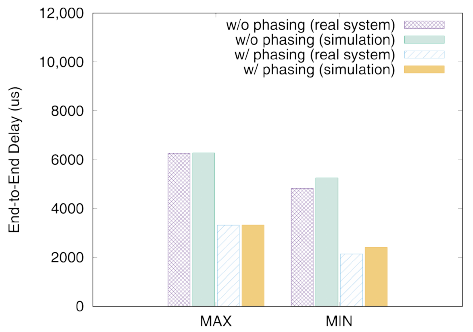
Figure 12. Max and min D e 2 e of VC 1 in test set 0.